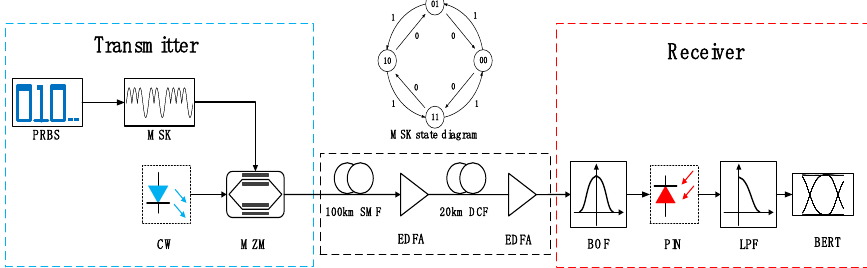
Fig.1. SOFC system using MSK downlink